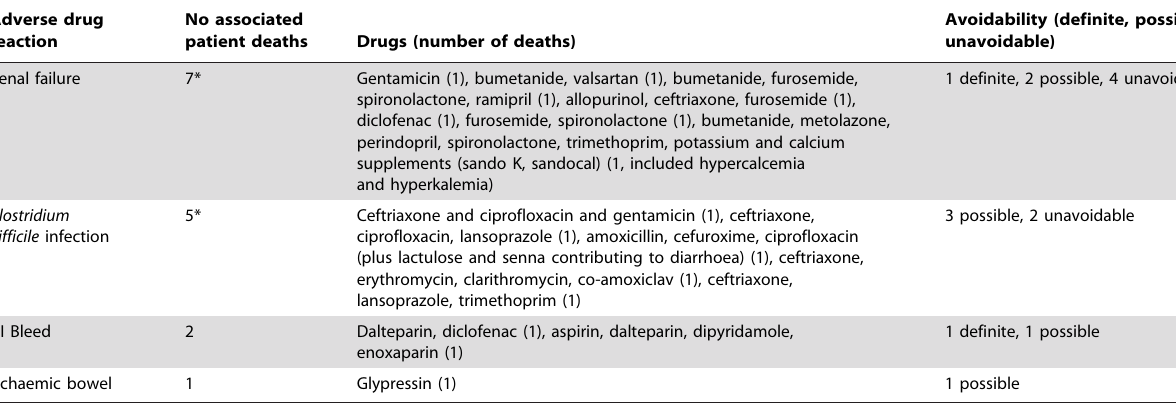
Table 2. Deaths associated with adverse drug reactions.